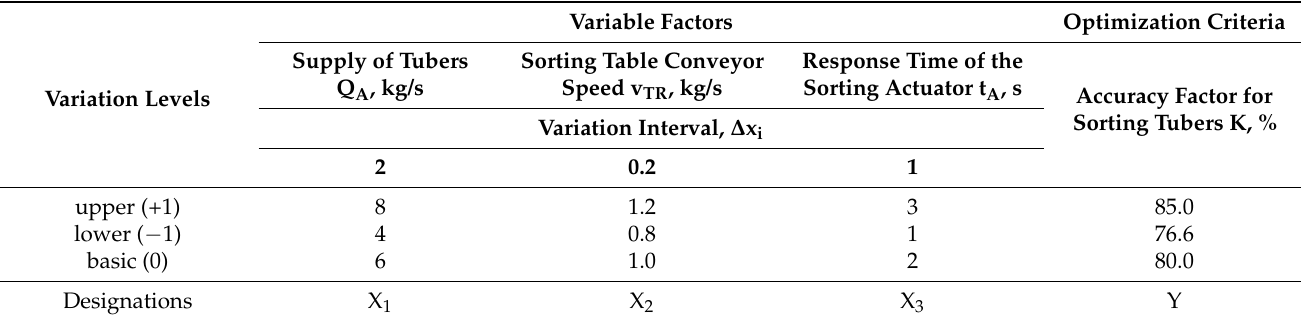
Table 1. Levels of variation of factors when sorting bulbs with the line for the post-harvest processing of root and tuber crops and onions with an automatic control system. Variable Factors Optimization Criteria Supply of Tubers Sorting Table Conveyor Response Time of Speed v TR , kg/s Variation Levels